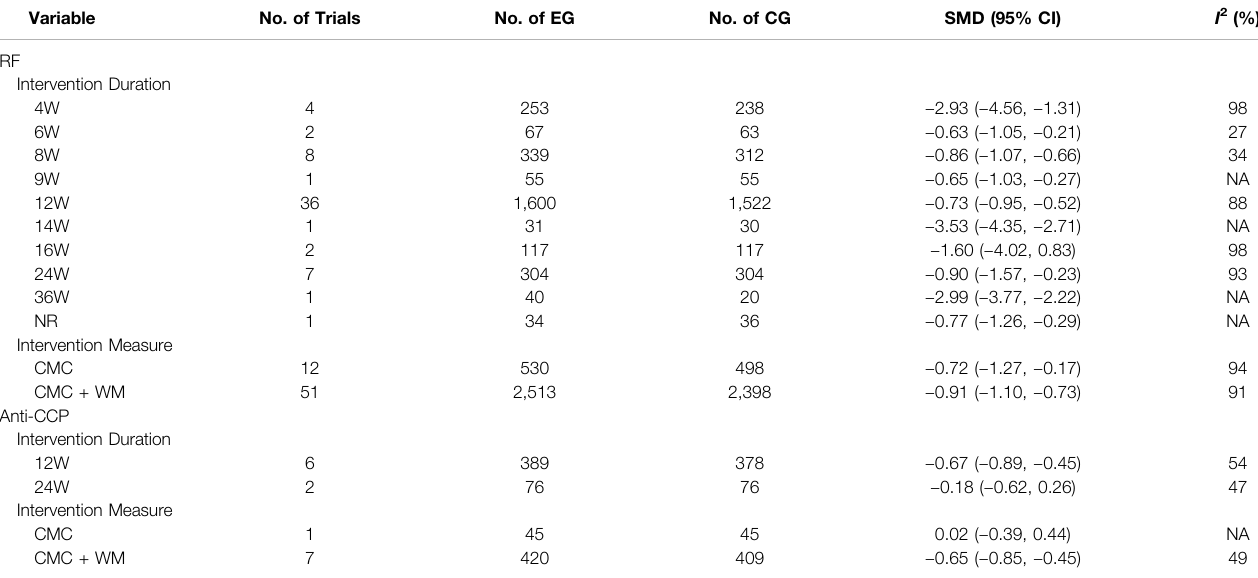
TABLE 3 | The results of meta-analysis of RF and anti-CCP subgroup analysis.